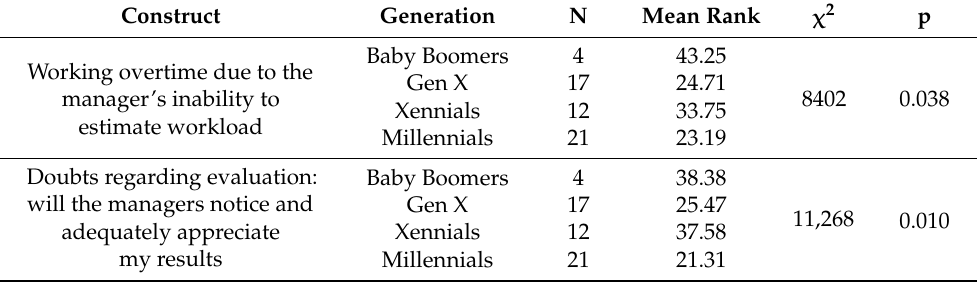
Table 4. The evaluation of teleworking among generations which have more than 3 years of telecom- muting